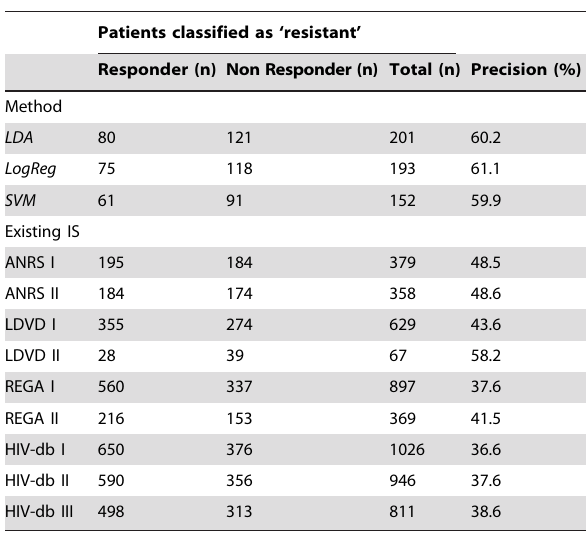
Table 3. Number of patient with a virological response or not among patients classified as ‘resistant’ and precision for the three statistical methods and existing IS on the entire data set (LDA: Linear Discriminant Analysis; LogReg: Logistic Regression, SVM: Support Vector